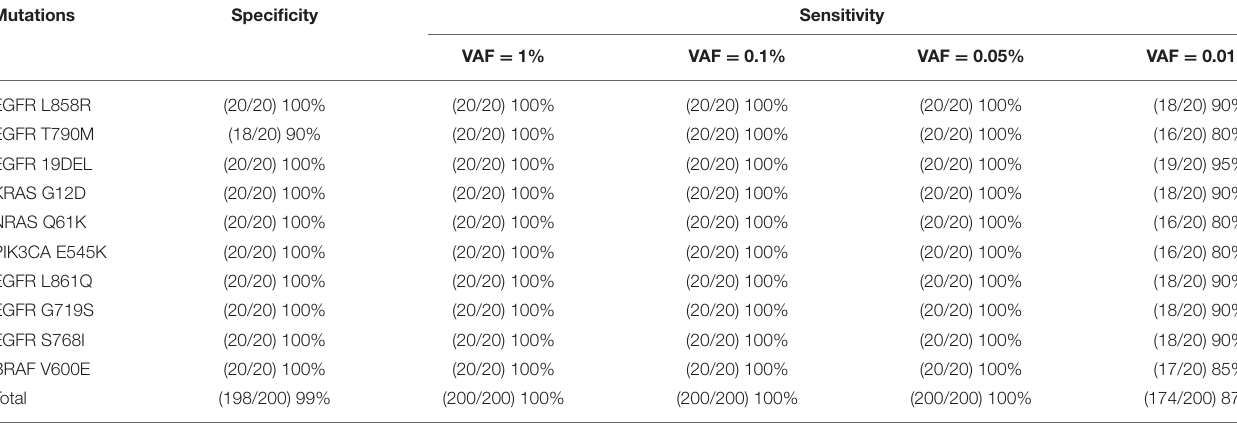
TABLE 1 | The specificity and sensitivity of PEAC enrichment followed by Sanger sequencing for the ten mutations in cfDNA reference standards. Mutations